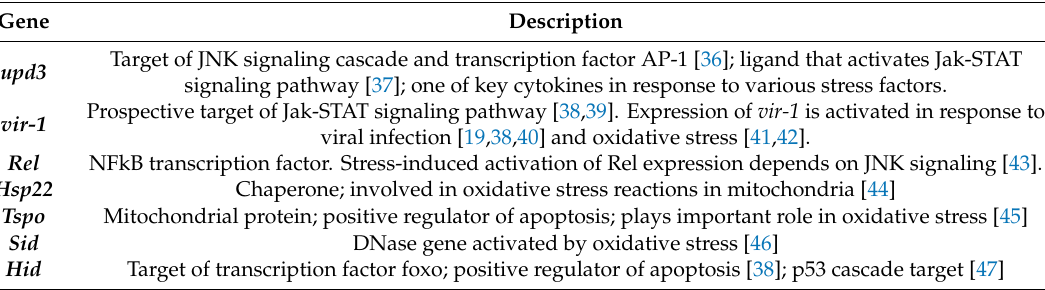
Table 3. Expression stress markers used in